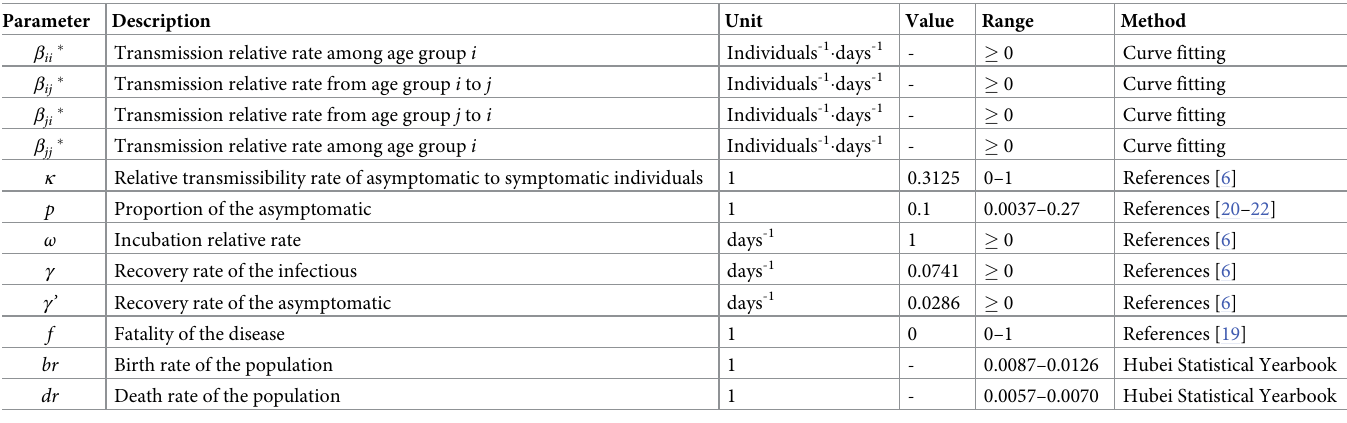
Table 2. Parameter description and values of SEIAR